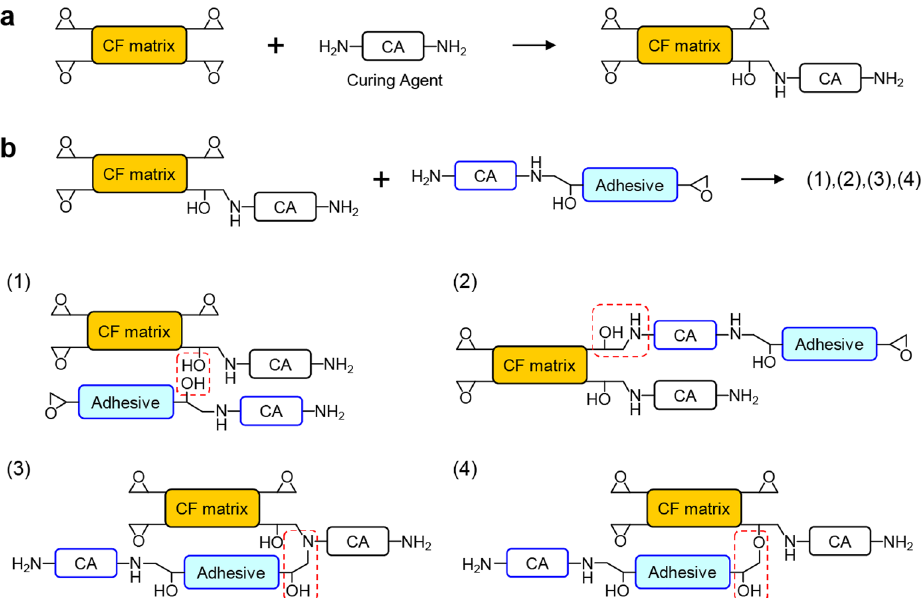
Figure 3. Chemical interactions between the CF matrix and the adhesive. ( a ) Schematics of the curing reaction between the epoxy-based CF matrix and the amine-based curing agent (CA). ( b ) Possible bonding models between the CF prepreg (T800S/3900-2B) and the adhesive film (FM309-1 M), where the reaction site is indicated by the dashed squares. (1) Hydrogen bond between the CF matrix and the adhesive film. (2) Curing reaction of the remanent epoxy group in the CF matrix with the primary amine in the adhesive film. (3) Curing reaction of the remanent epoxy group in the adhesive film with the secondary amine in the CF matrix. (4) Etherification of the remanent epoxy group in the adhesive film with the OH group in the CF